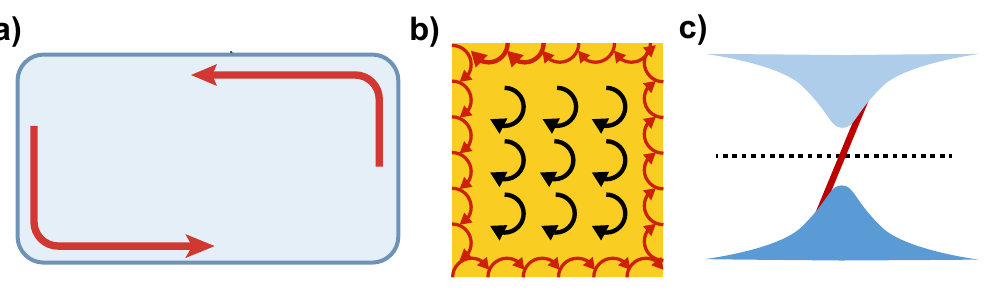
Figure 1: Topological insulators in a nut shell. (a) Topological insulator: a two-dimensional (2D) material that is insulating in the bulk but exhibits perfect conduction on the edge. (b) Simplified sketch of the integer quantum Hall effect, which was the first topological insulator. (c) Simplified dispersion relation for the quantum Hall effect, with the red line marking the topological edge